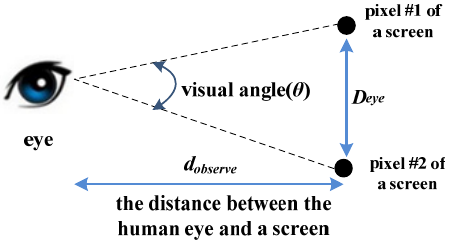
Figure 2. The simple model of the human eye.